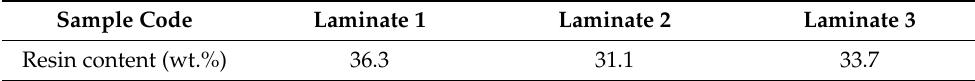
Table 2. The formulation of composites and resin content.